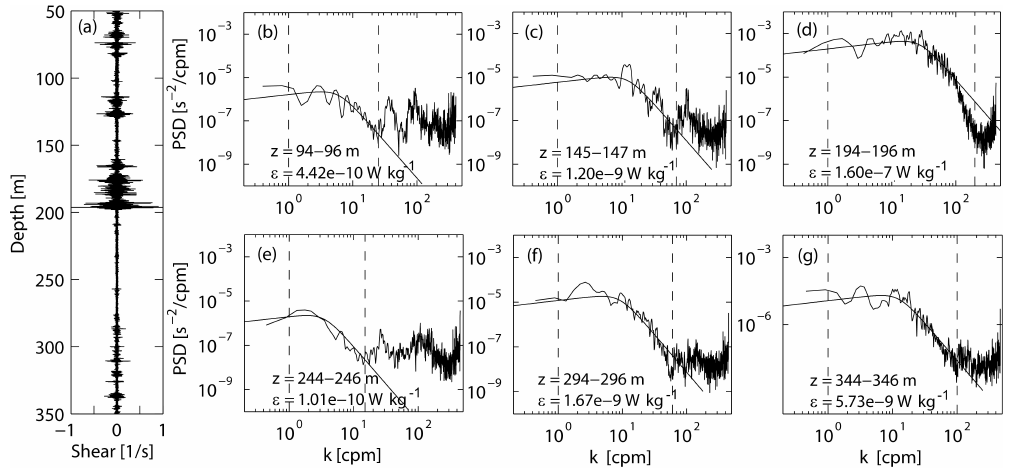
Figure 2. Examples of (a) micro-shear and (b–g) shear spectra at different depths. The integration bounds (vertical dashed lines) and Nasmyth spectra (smooth curves) are